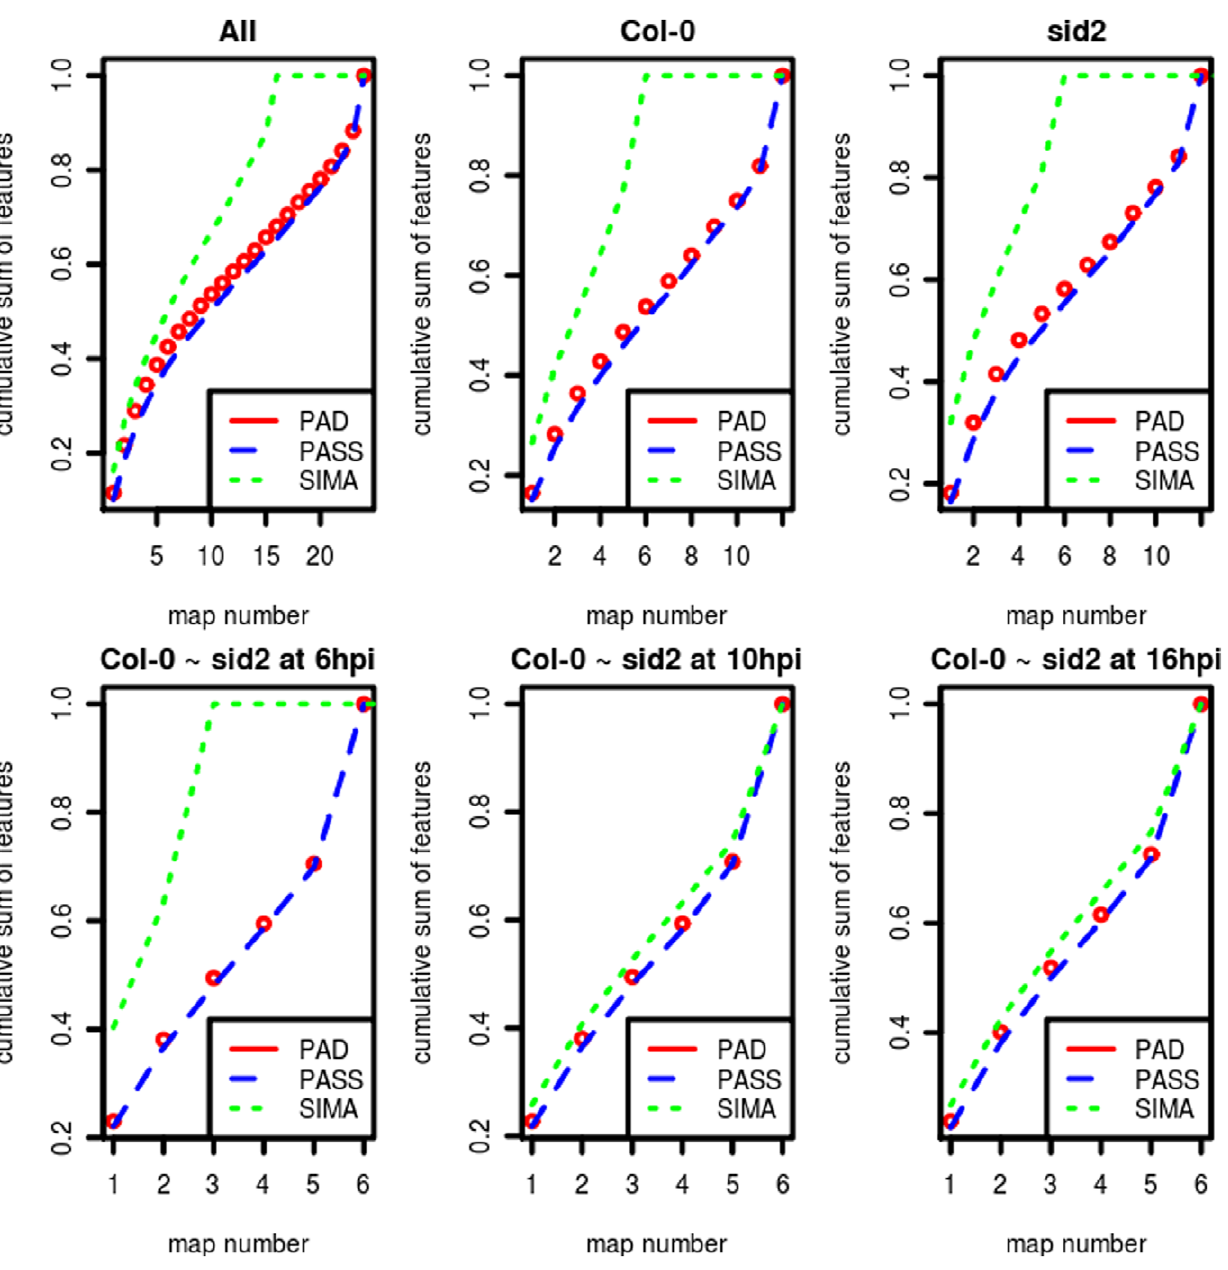
Figure 3. Characteristic alignment map (CAM) curves. The CAM was generated for MCM analysis of six alignments on the real data of pathogen infected plant leaves. The horizontal axes represent the maps used for each alignment, i.e. from six to 24. The vertical axes represent the cumulative sum of aligned features or the size of consensuses. The open dots represent CAM curves of PAD. Dashed lines represent CAM curves of PASS and dotted lines represent CAM curves of SIMA (mass resolution 0.0071).